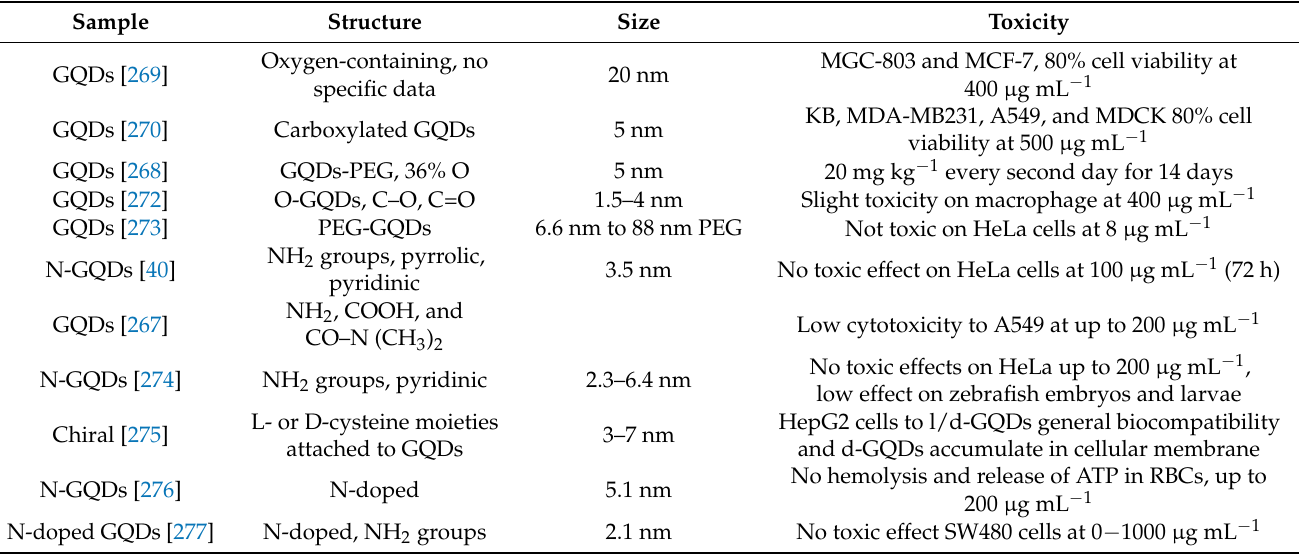
Table 6. Toxicity of GQDs with different sizes and